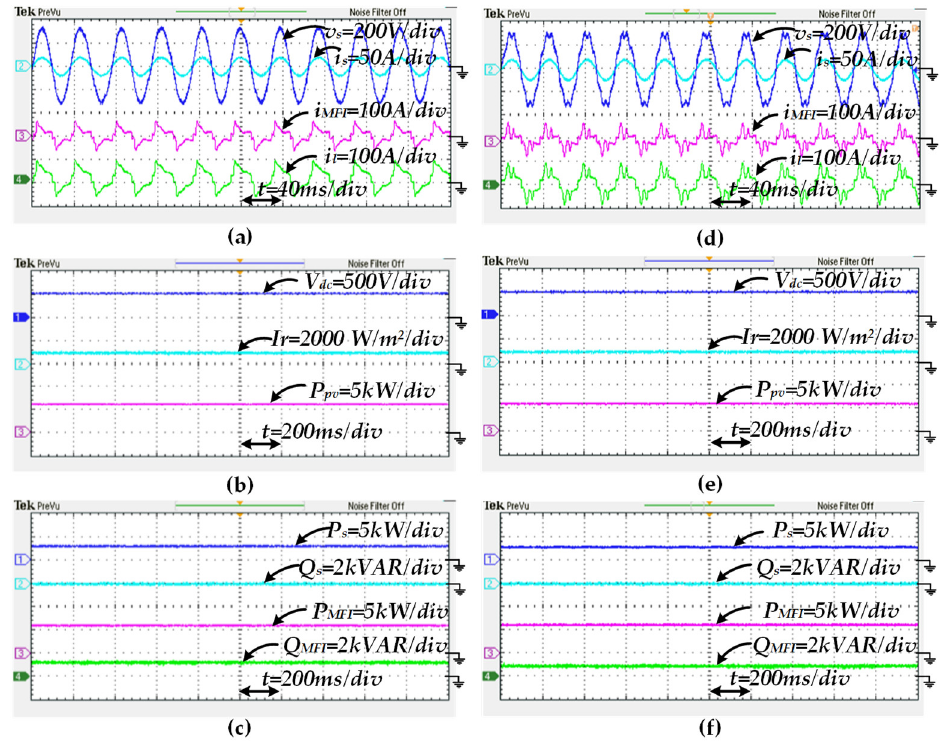
Figure 14. RT SIL test output waveforms under the MFI ON, with grid sharing and power conditioning mode; ( a ) ideal grid input voltage, current, MFI current, and load current; ( b ) MFI DC-link voltage, solar irradiation, and PV power under the ideal grid; ( c ) source active power, reactive power, and MFI active and reactive power under the ideal grid; ( d ) distorted grid input voltage, current, MFI current, and load current; ( e ) MFI DC-link voltage, solar irradiation, and PV power under the distorted grid; ( f ) source active power, reactive power, MFI active and reactive power under the distorted grid.